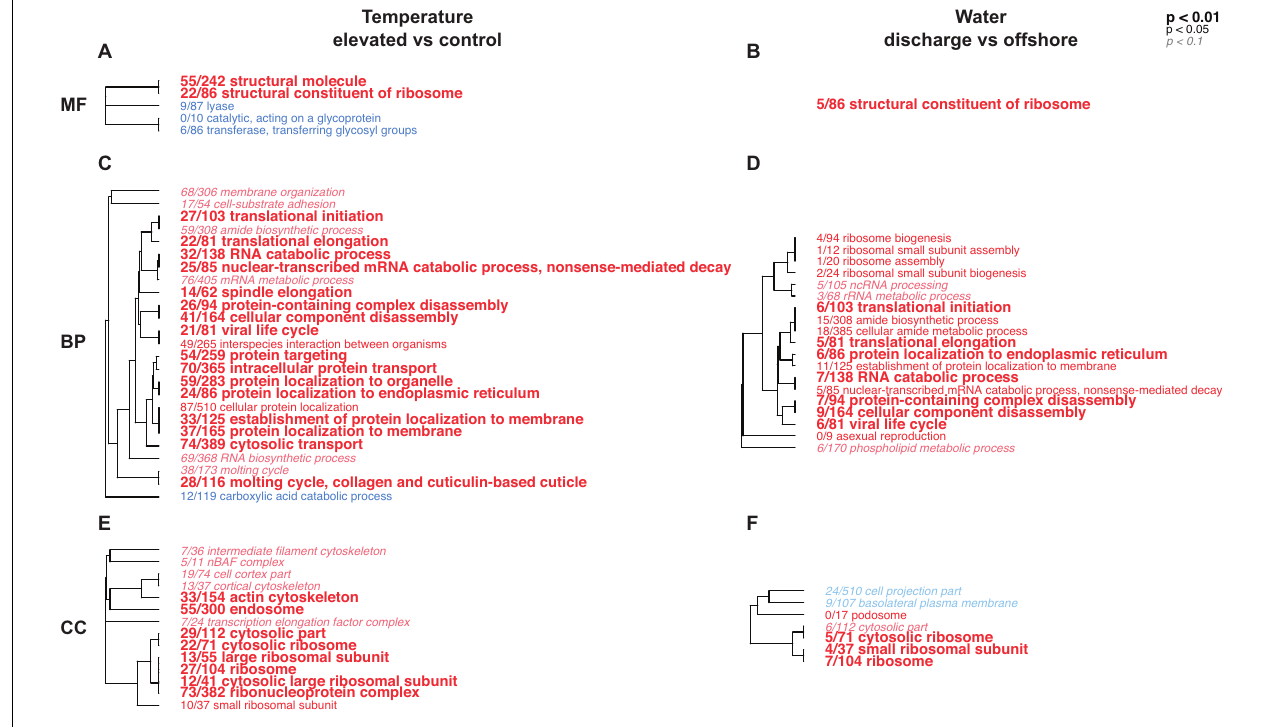
FIGURE 5 | Hierarchical trees representing significantly enriched gene ontology (GO) categories in pairwise comparisons between temperature and water treatments in the coral host dataset for the ex situ experiment. Blue terms represent under-expressed GO categories in (treatment/control), while red terms indicate over-expressed GO categories in (treatment/control). The size and typeface of the font correspond to the p value threshold, where larger, bolded GO terms are more significantly enriched compared to smaller, italicized GO terms, and the number fraction refers to the number of genes represented in each GO category. Annotations are presented for molecular function (MF; A,B ), biological process (BP; C,D ), and cellular component (CC; E,F ) GO